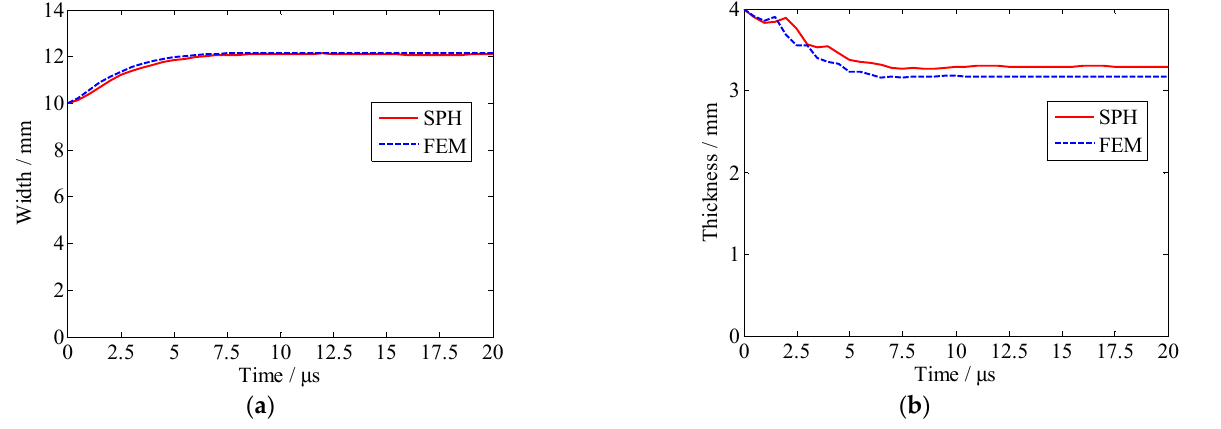
Figure 12. Comparison of width and thickness of the upper block calculated by SPH and FEM: ( a ) Width; ( b ) Thickness.